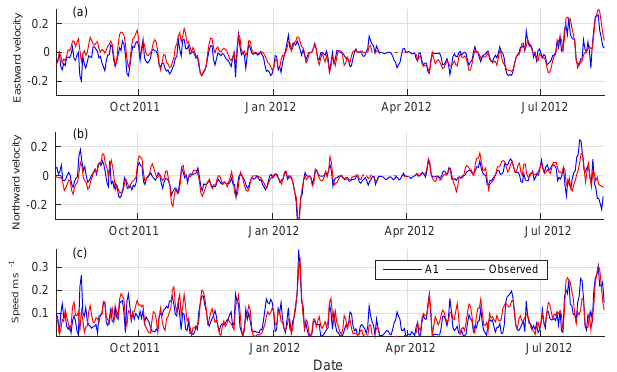
Figure 4. Time series of sea ice velocity components and speed of ITP 53 vs. 36km horizontal resolution of MITgcm (A1). The cor- relations between eastward, northward and magnitude of velocity between ITP 53 data and A1 are 78, 75 and 80%,